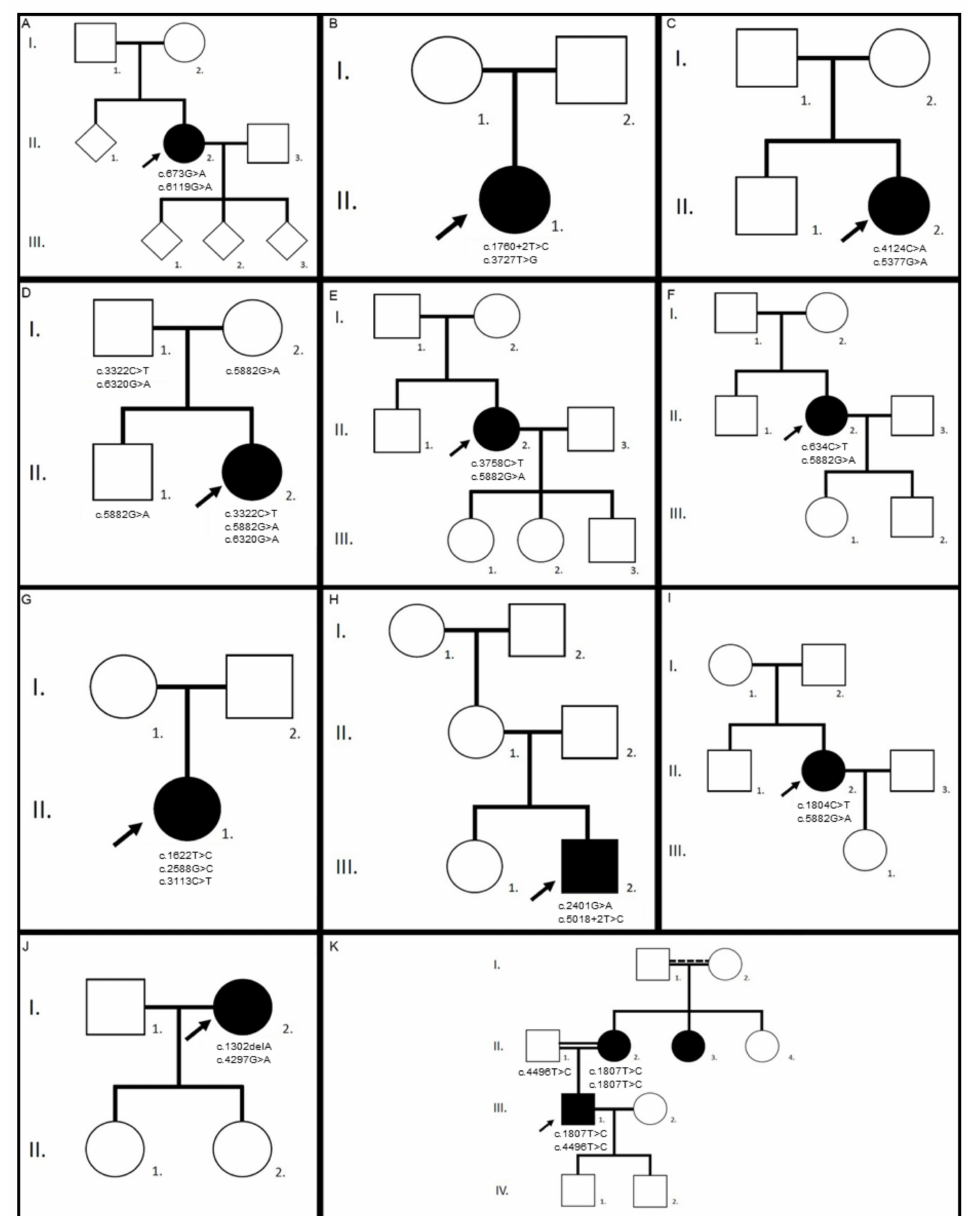
Figure 1. Family trees of the ABCA4 cohort. In each pedigree, the arrow indicates the proband. Family 1, patient II.2 ( A ), family 2, patient II.1 ( B ), family 3, patient II.2 ( C ), family 4, patient II.2 ( D ), family 5, patient II.2 ( E ), family 6, patient II.2 ( F ), family 7, patient II.1 ( G ), family 8, patient III.2 ( H ), family 9, patient II.2 ( I ), family 10, patient I.2 ( J ), and family 11, patient III.1 ( K ). Identified pathogenic variants are further detailed in Table